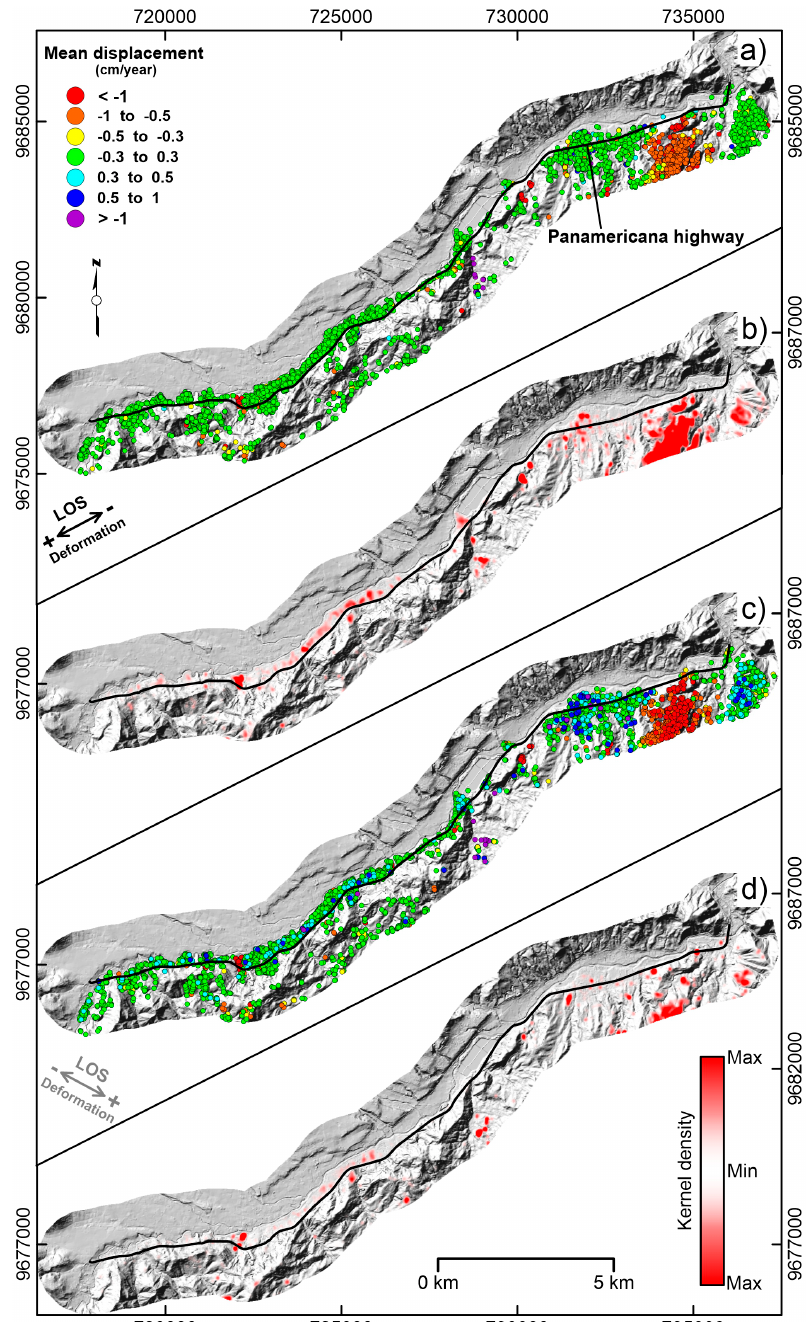
Figure 6. SCS mean displacement rate maps for ascending ( a ) and descending ( c ) acquisition geometry. The results of KDE algorithm are shown in ( b , d ), respectively. The biggest red cluster in the northern area visible both in ascending and descending displacements maps could be explained as a deformation movement with major component along the vertical axis.